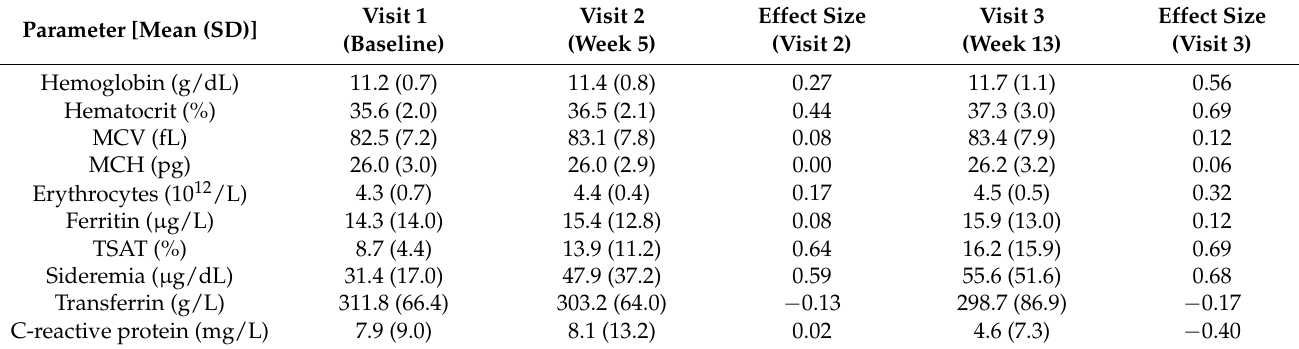
MCV: mean corpuscular volume; MCH: mean corpuscular hemoglobin; TSAT: transferrin